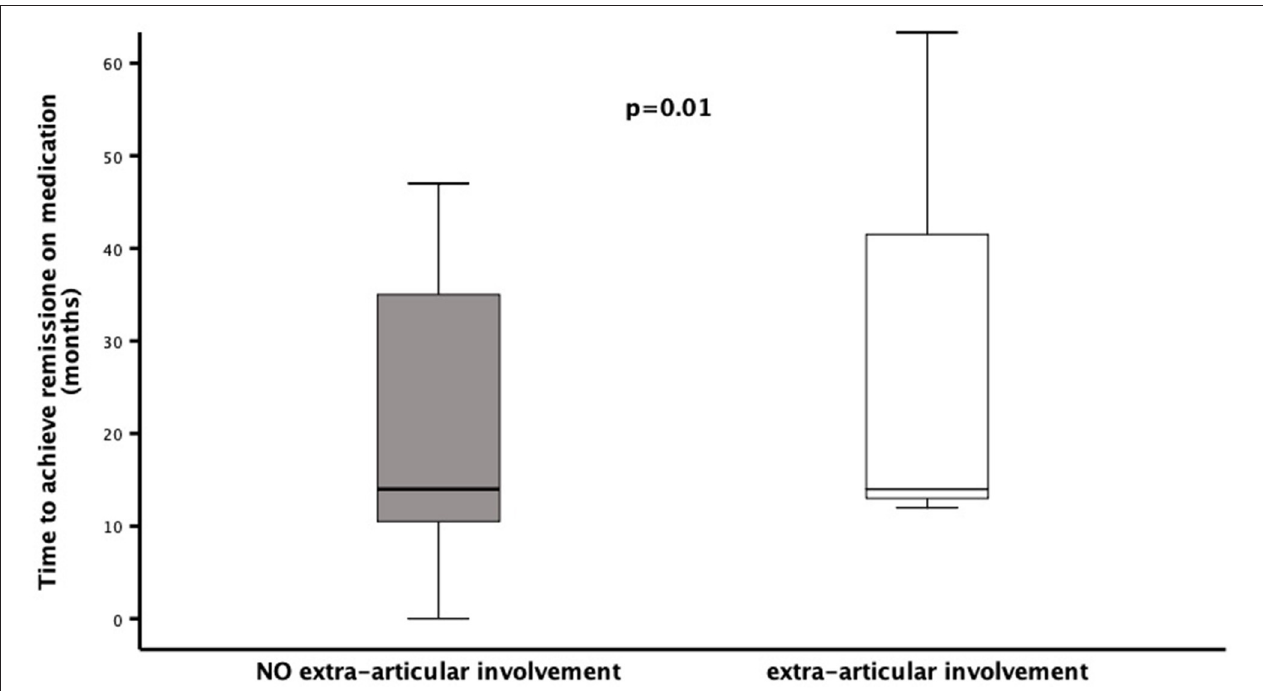
FIGURE 2 | Time to reach clinical remission on medication in a cohort of 53 children diagnosed as ERA-JIA at the onset of disease. Figure shows the time to reach clinical remission on medication (months) in 3 ERA-JIA children with extra-articular involvement (white box) and in 22 ERA-JIA children without extra-articular manifestations (gray box). The central line represents the distribution median, boxes span 25th to 75th percentiles, and error bars extend from 10th to 90th percentiles. Dots are values higher than the 90th percentile. ( p = 0.002). ERA-JIA, enthesitis-related arthritis juvenile idiopathic arthritis.